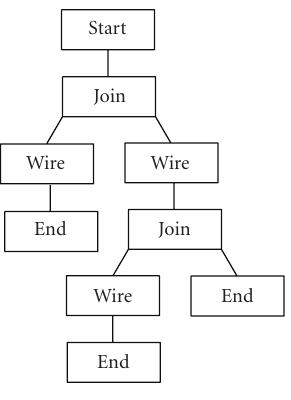
Figure 1: The tree structure representing the function S ( x 0 , J ( W ( x 1 , E ), W ( x 2 , J ( W ( x 3 , E ), E ))). The x i are coordinate vectors for the relative positions of the structure